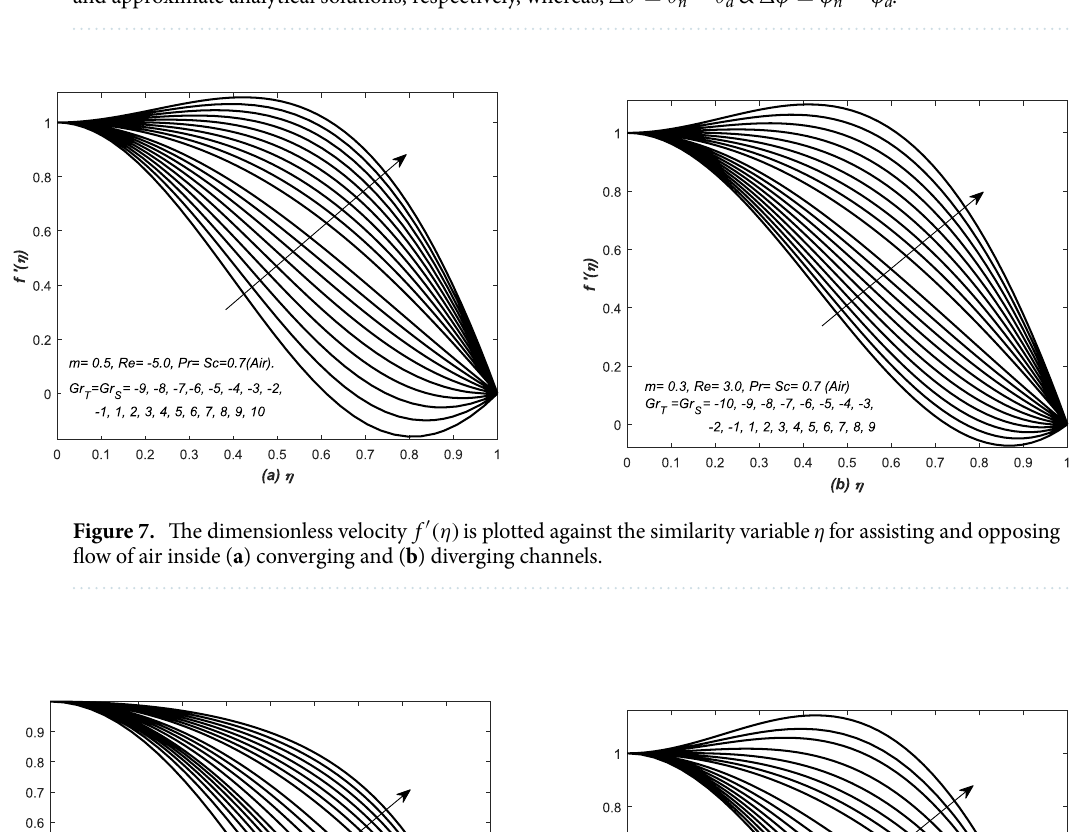
Table 1. The comparison of approximate analytical solution in Eqs. (21–23) with numerical solutions of the unknown functions in Eqs. (11–14) where the subscripts n and a of the variables f , θ , φ are used for numerical and approximate analytical solutions, respectively, whereas, �θ = θ n − θ a & �φ = φ n − φ a .